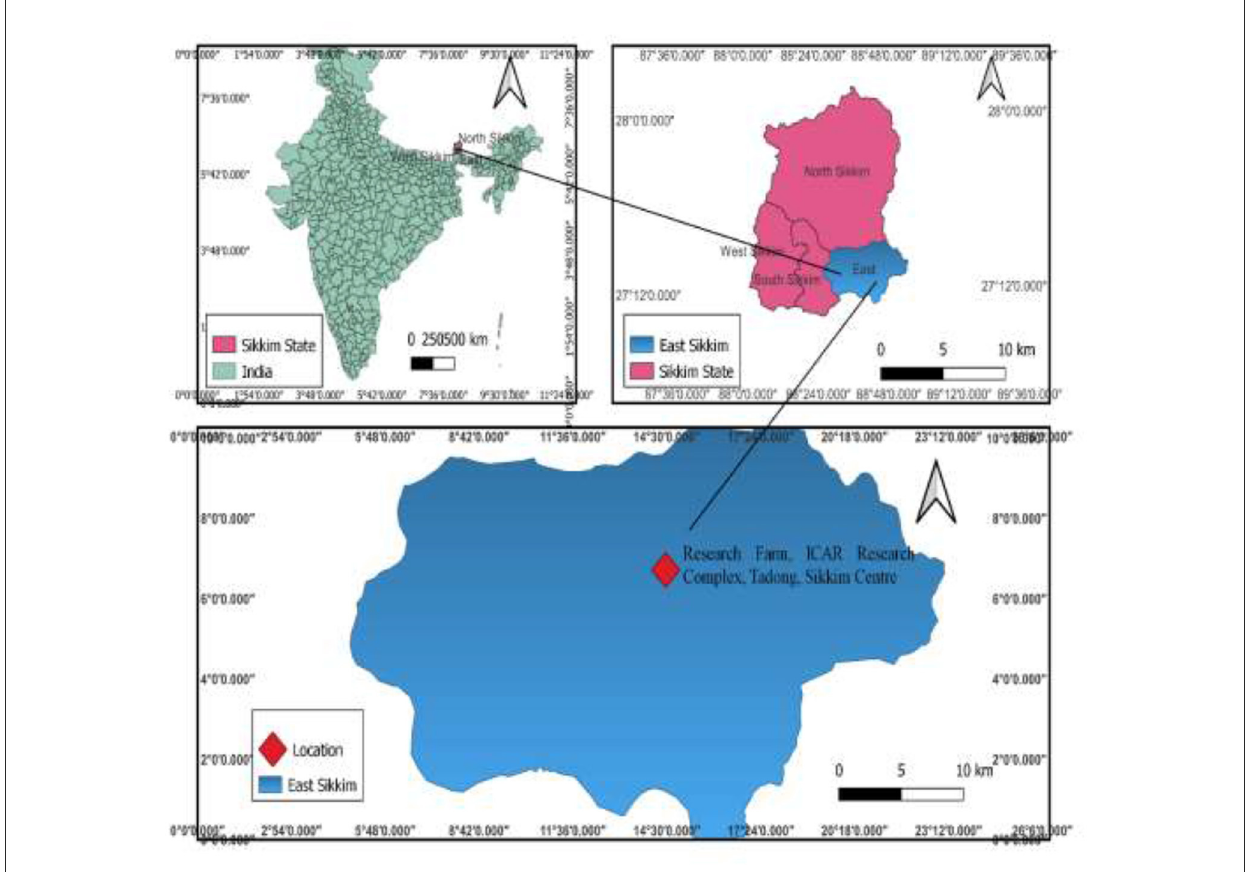
FIGURE1 Study site in Eastern Himalayan